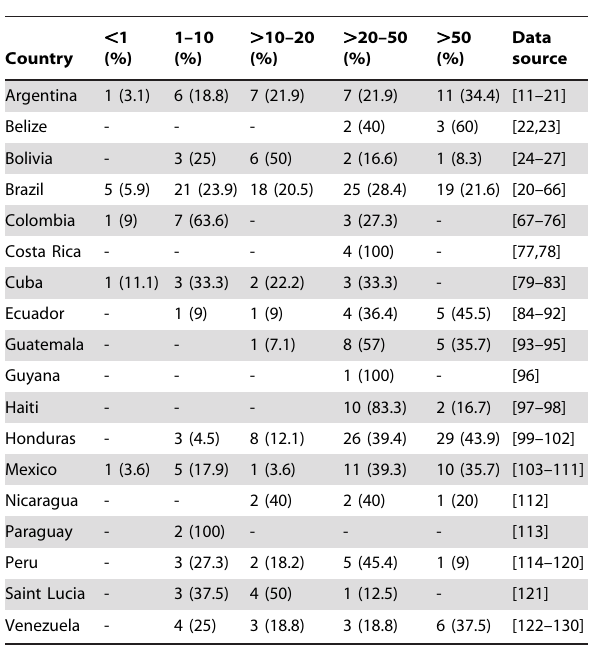
Table 1. Number and relative frequency of data points found for STH prevalence ranges by country, LAC